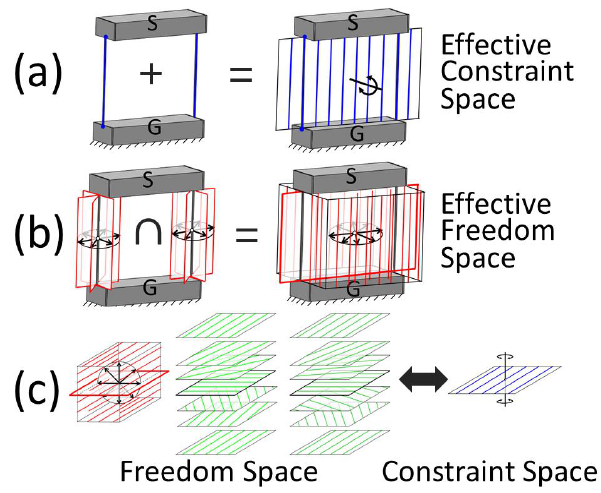
Figure 6. Linearly combine constraints in parallel (a) or find the intersection of their freedom spaces (b) to find the system’s complementary freedom and constraint spaces (c)